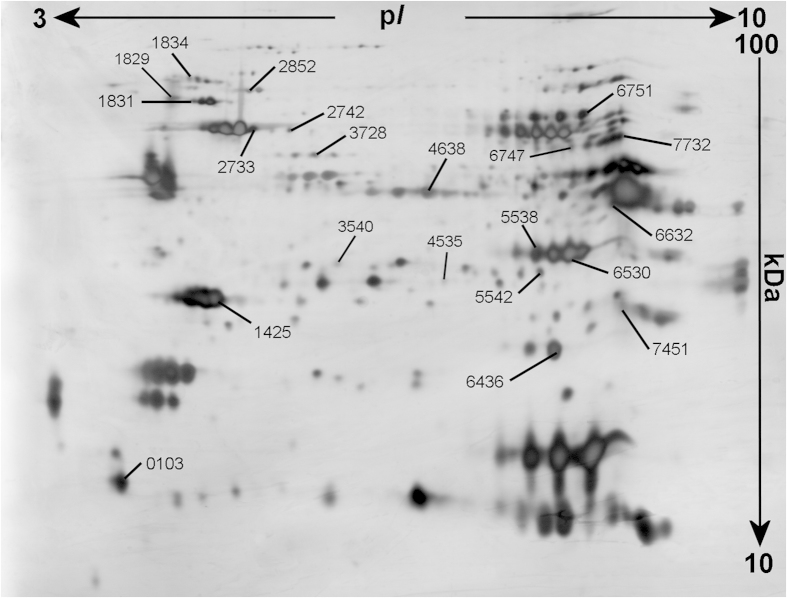
An analytical 2-DE pattern from human trapezius muscle.Numbers represent the identified proteins significantly altered according to the univariate and multivariate analysis, i.e. between groups (CWP vs CON). Horizontally the proteins are separated according to isoelectric point (pI) and vertically based on their molecular weight (MW).